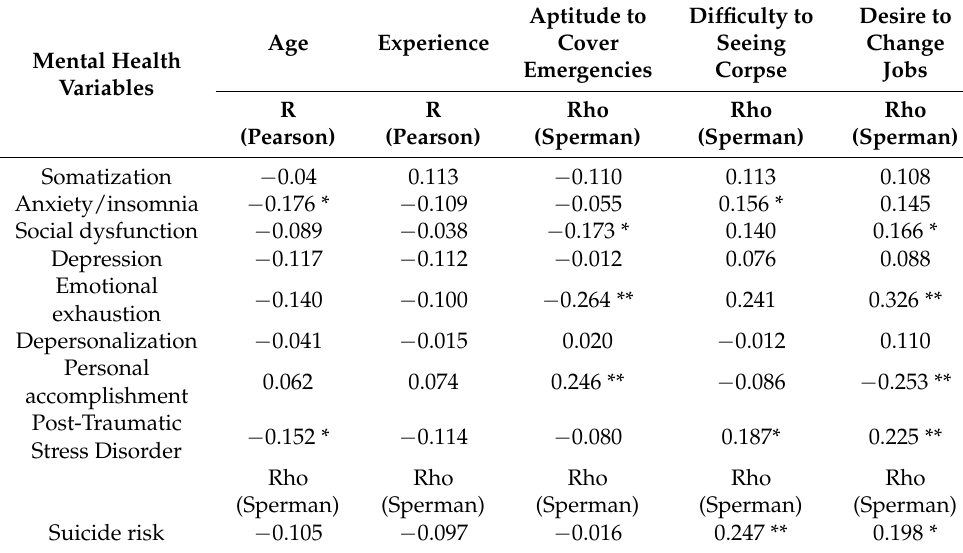
Table 4. Correlations between mental health and labor variables.